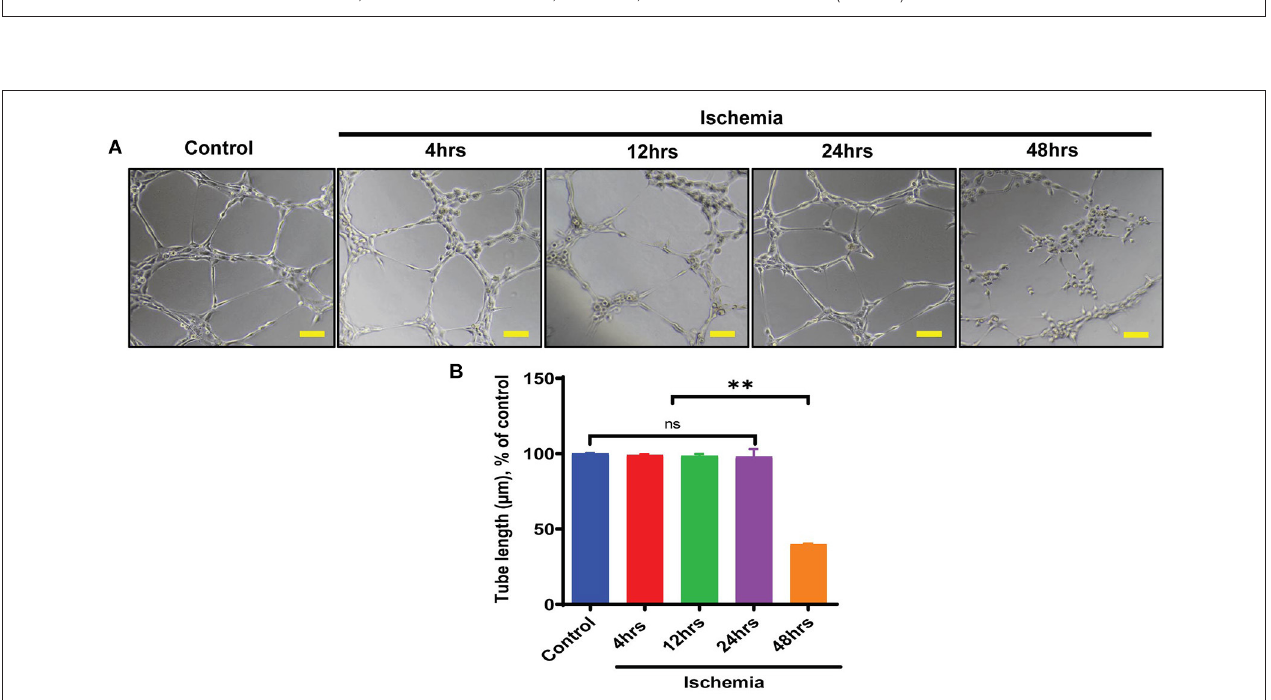
FIGURE 2 | Endothelial cell tube formation was measured following ischemic stress. (A) HMVE were cultured under ischemia for indicated time points in low serum media. For the tube formation analysis, cells were trypsinized and seeded on matrigel. (B) The images were taken at 100X magnification and tube length was measured with ImageJ (NIH) software (total 40–50 branch points were measured to take the average for each specimen).The scale bar on Image represents 50 µ M pixel size. ** P < 0.01, control vs. 48 h ischemic stress. ns indicates not significant ( n = 3–5).